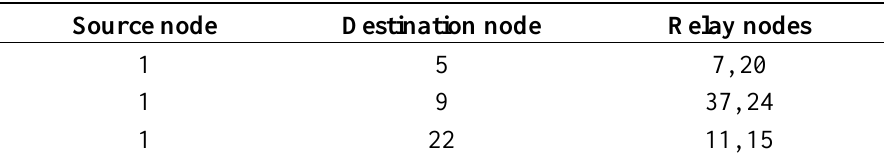
Table 1. Example of